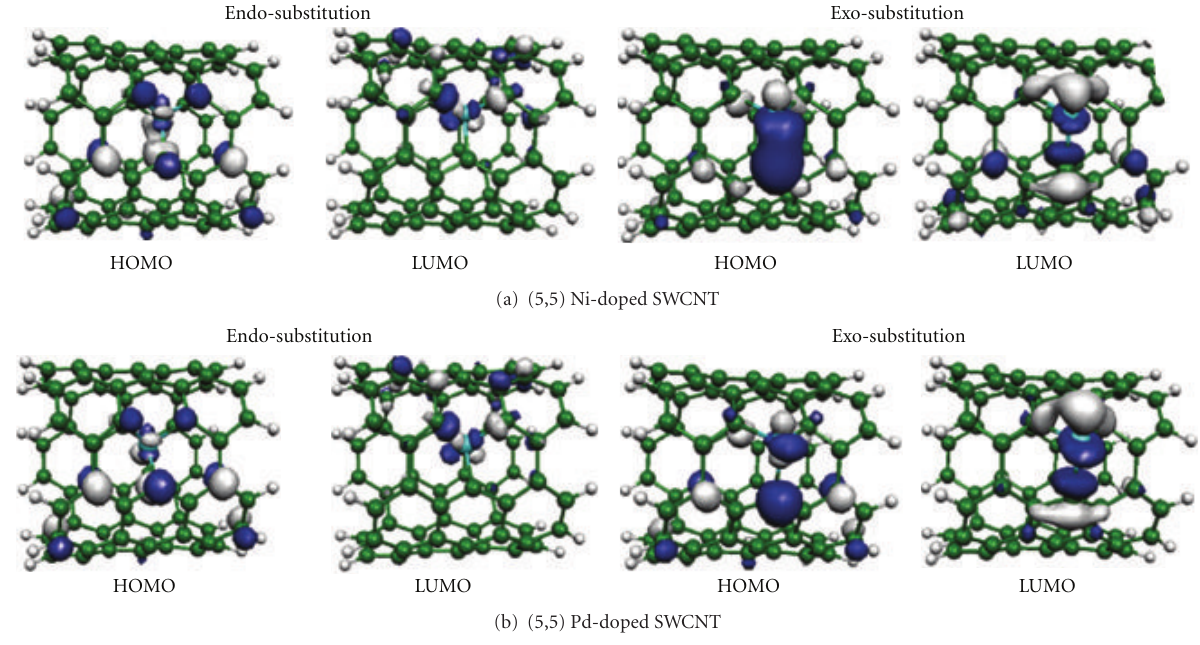
Figure 12: FMOs of Ni- and Pd-doped SWCNTs